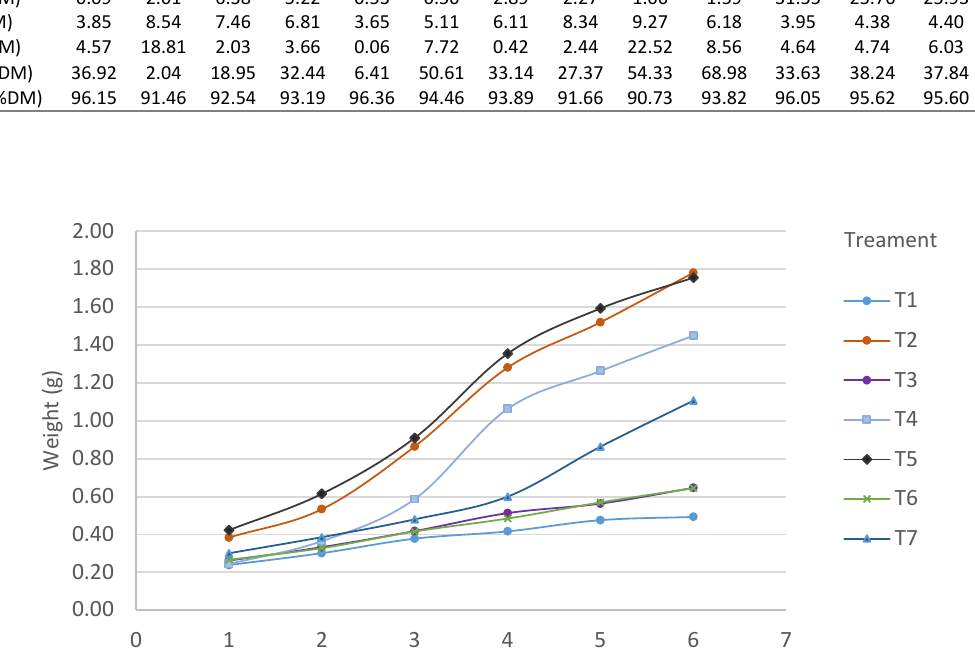
Fig. 1: Weight of Hermetia illucens larvae for each treatment over time. Larval growth system (T1: raw beef blood, T2: raw beef viscera, T3: cooked beef blood, T4: cooked beef viscera, T5: control (balanced feed), T6: raw chicken viscera, and T7: cooked chicken viscera)